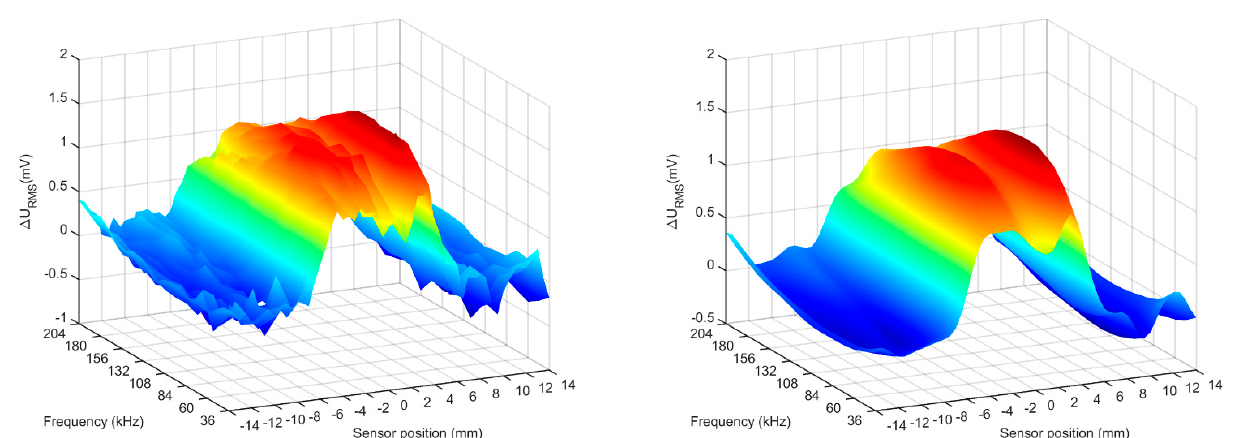
Figure 15. Comparison of the results for the 10% flaw depth for different excitation pulse powers. Results are shown with and without filtering.